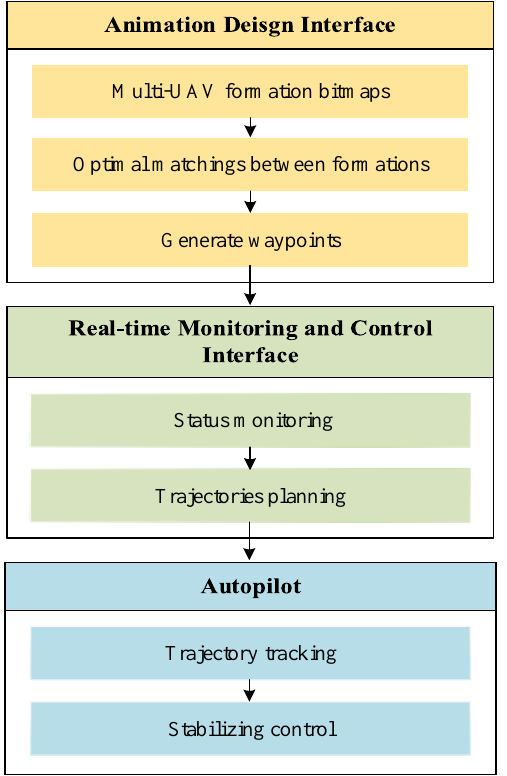
Figure 4. Software components of the UAV-LS